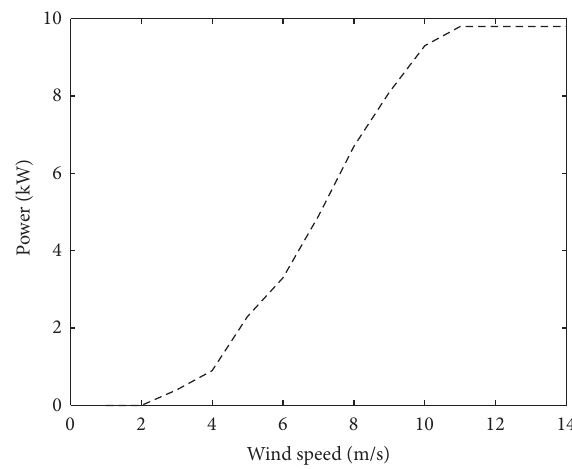
F 1: Power curve of the 10kW Aricon HAWT wind